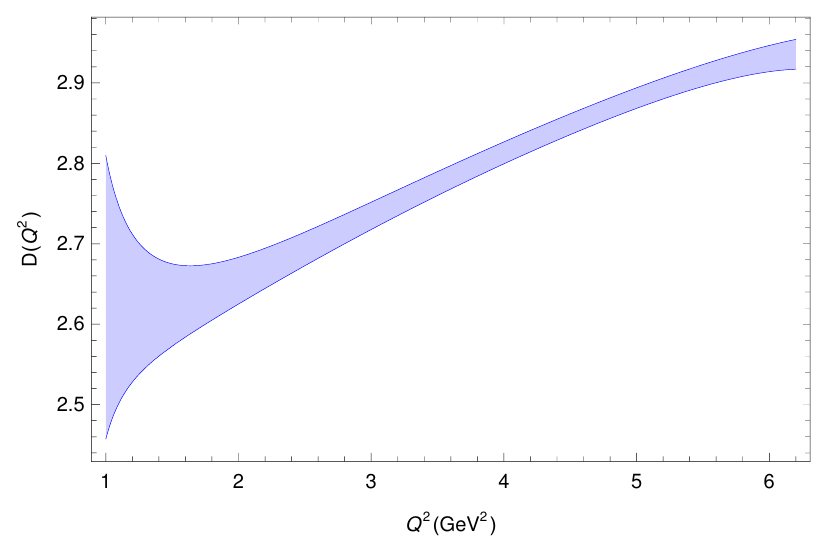
Figure 10 . Final result for the perturbative D ( Q 2 ) with α ( n f =5) s ( M 2 with its uncertainty.